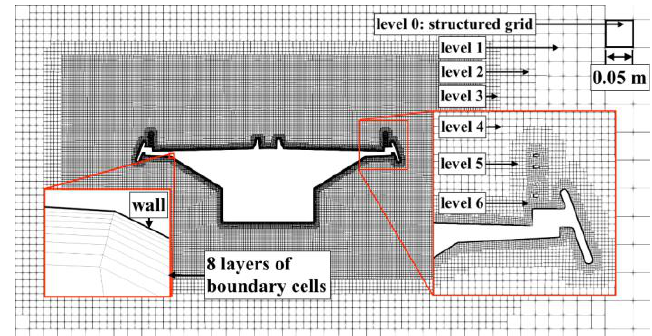
Figure 13. Details of mesh No.4.